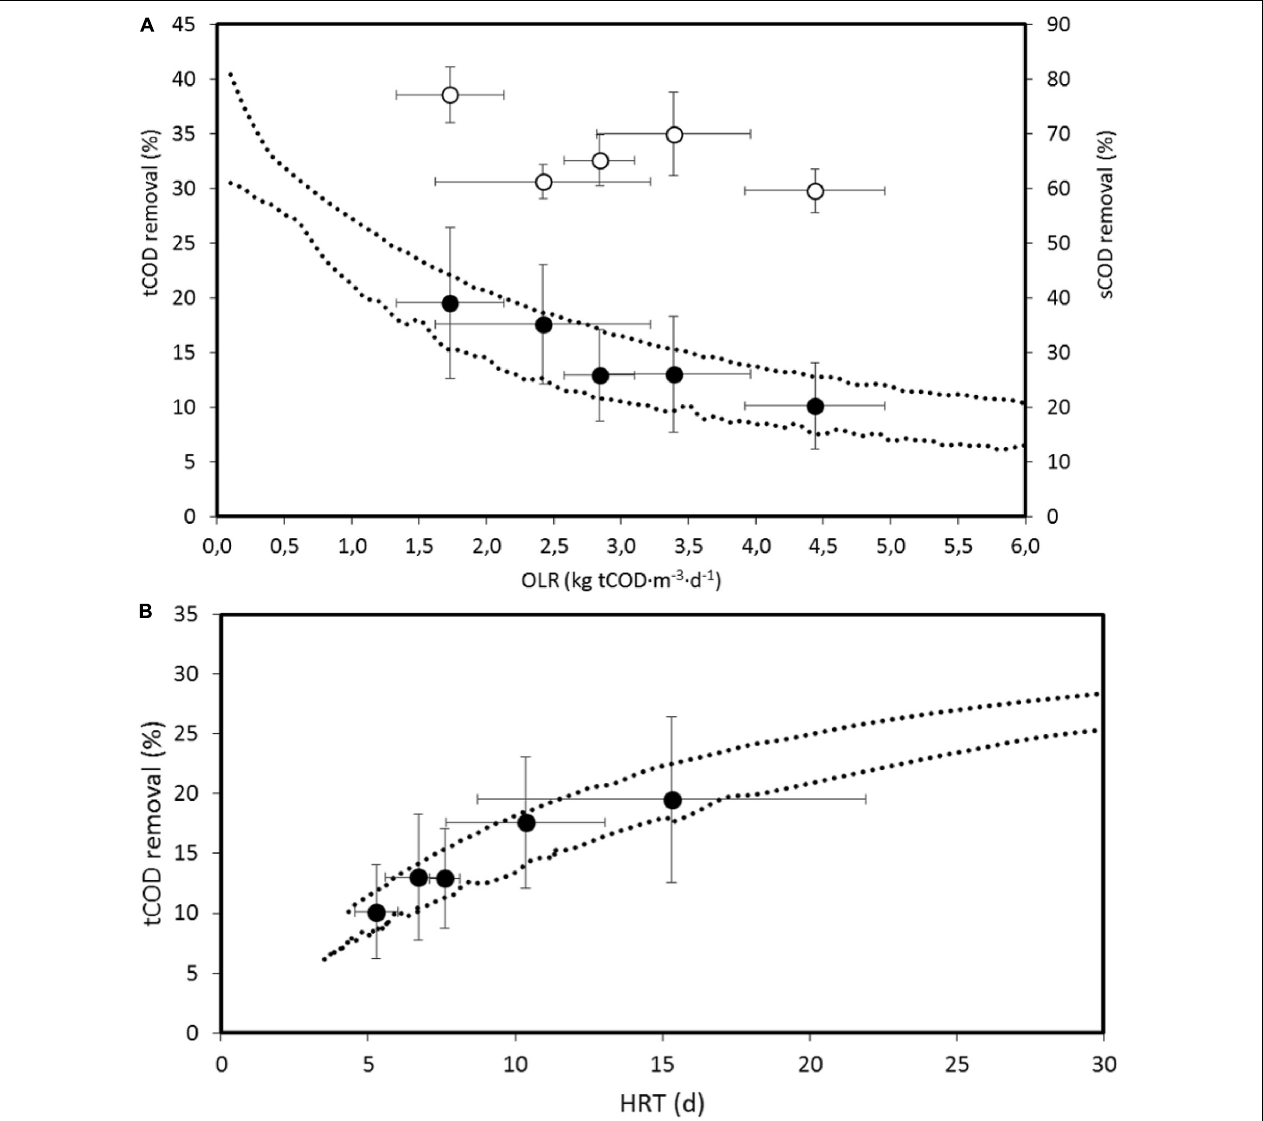
FIGURE 3 | (A) Estimated 95% confidence interval (CI) by model 2 of tCOD removal and average experimental values of tCOD and sCOD as a function of the organic loading rate (OLR). Error bars are standard deviations. (B) tCOD removal as a function of the hydraulic retention time (HRT), with indication of the 95% CI estimated by model 2. Error bars are standard